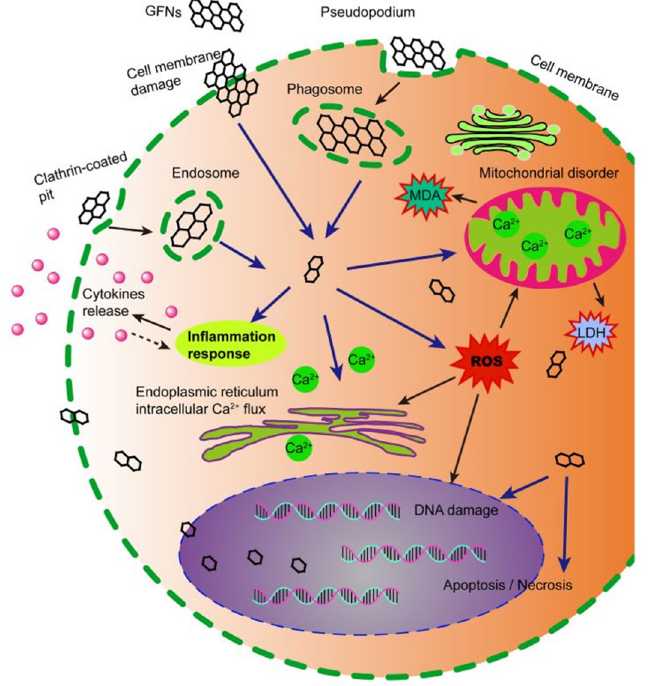
Figure 18. Schematic diagram showing the possible mechanisms of CBM cytotoxicity. CBM get into cells, which induces ROS generation, lactate dehydrogenase and malondialdehyde increase, and Ca 2+ release. Subsequently, CBM cause kinds of cell injury, for instance, cell membrane damage, inflammation, DNA damage, mitochondrial disorders, apoptosis, or necrosis. Reproduced from Ref. [141] with permission from Springer Nature. Copyright 2016 Springer